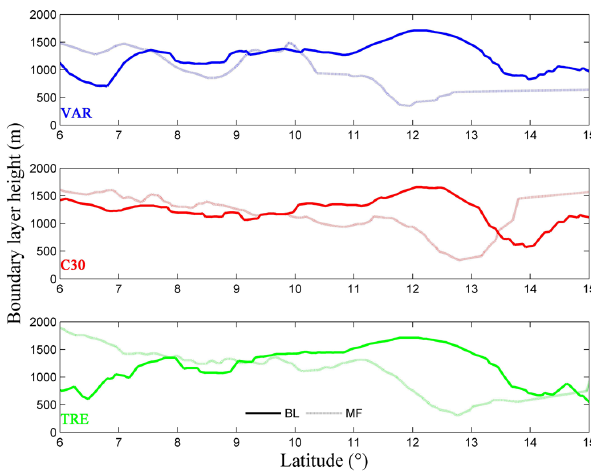
Fig. 14. Height of the boundary layer (BL, solid line) and the mon- soon flux (MF, dashed line) as a function of latitude for three sim- ulation runs on 13 June 2006 12:00UTC. VAR: variable vegetation cover, C30: constant surface cover of cropland, TRE: constant sur- face cover of